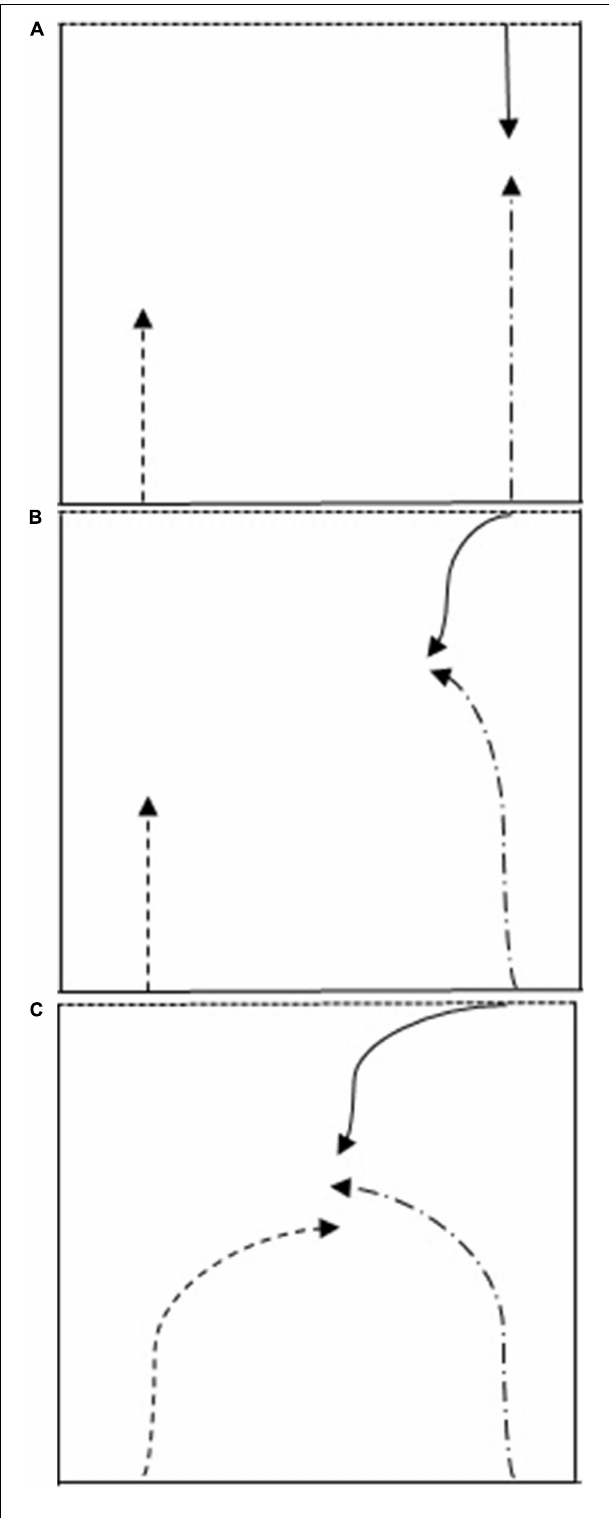
FIGURE 1 | (A) Spin pass. The participant (Long Dash Dot arrow) runs toward the defender (Solid arrow). The ball is passed to the support player (Dash arrow) who runs toward and places the ball on the ground after the try line